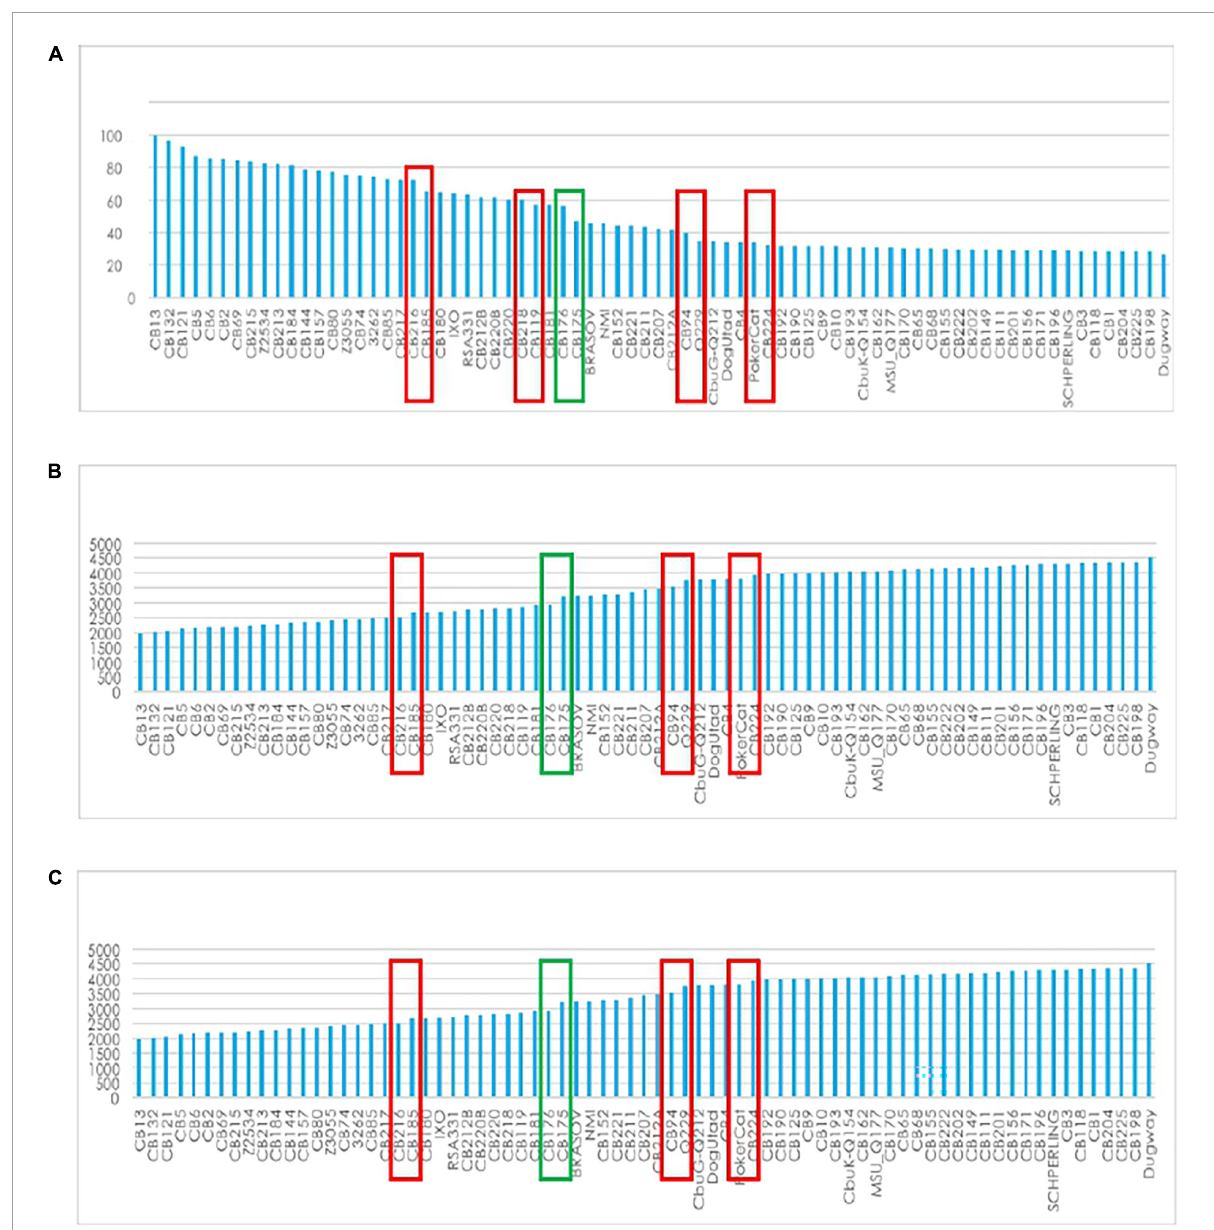
FIGURE3 Gene variation. (A) Core/pangenome ratio (B) : total genes; (C) core gene variation with the addition of new genome